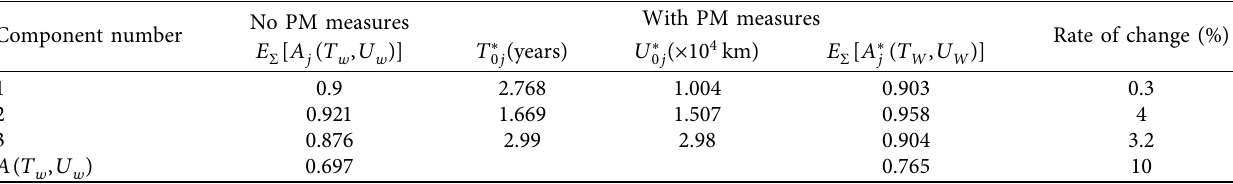
Table 4: Comparison of the availability with PM measures and without PM measures.